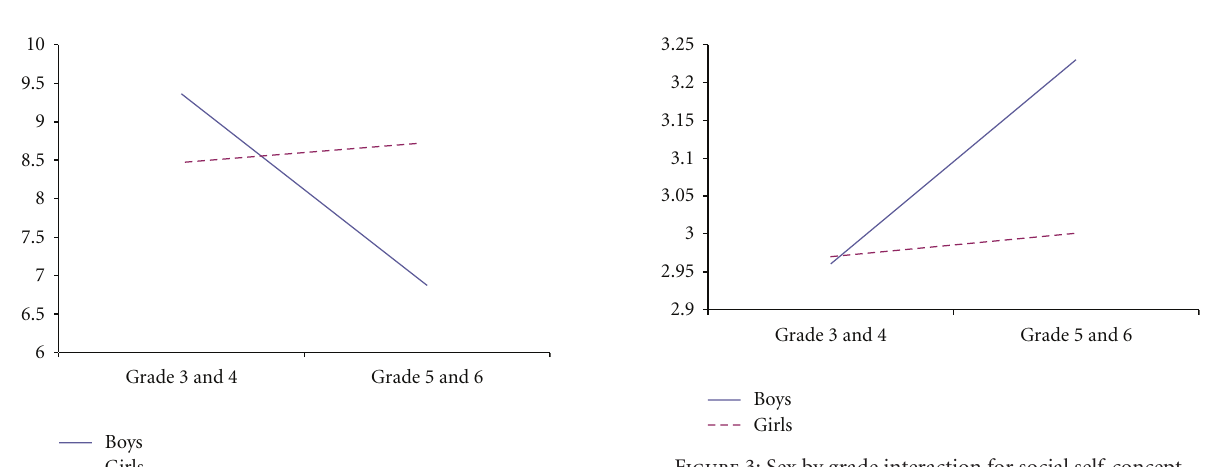
Figure 3: Sex by grade interaction for social self-concept.